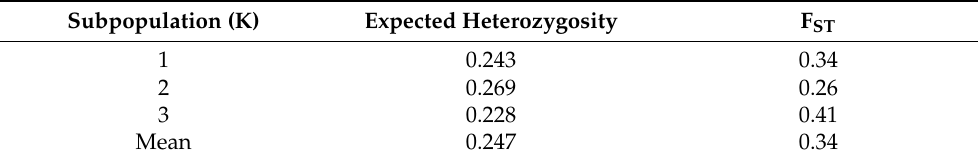
Table 10. Expected heterozygosity and FST values in bean